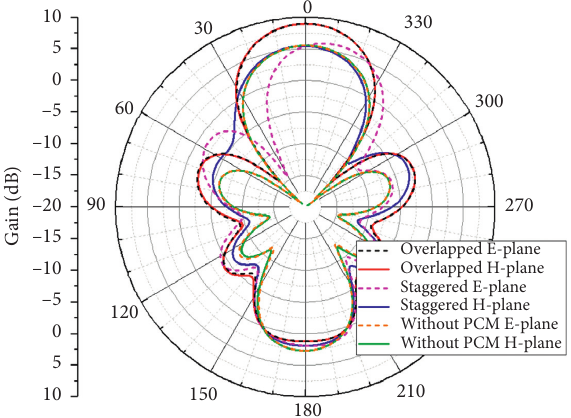
Figure 11: The pattern of different arrangements of slots and PCMs.